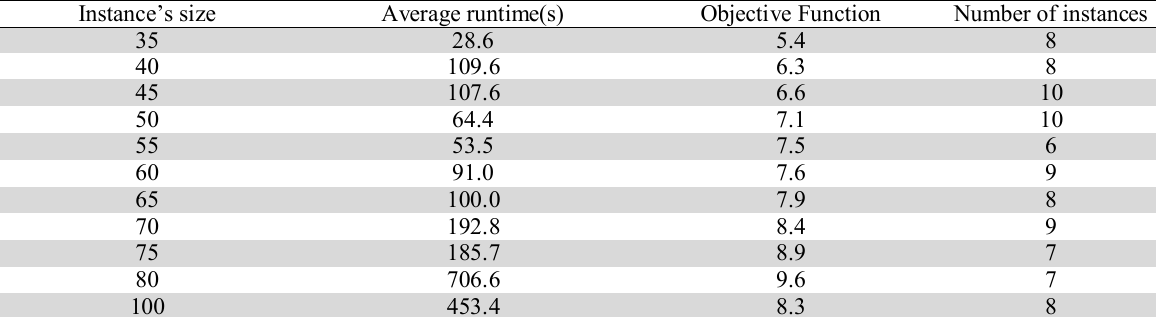
Instances solved to optimality Instance’s size Average runtime(s) Objective Function Number of instances